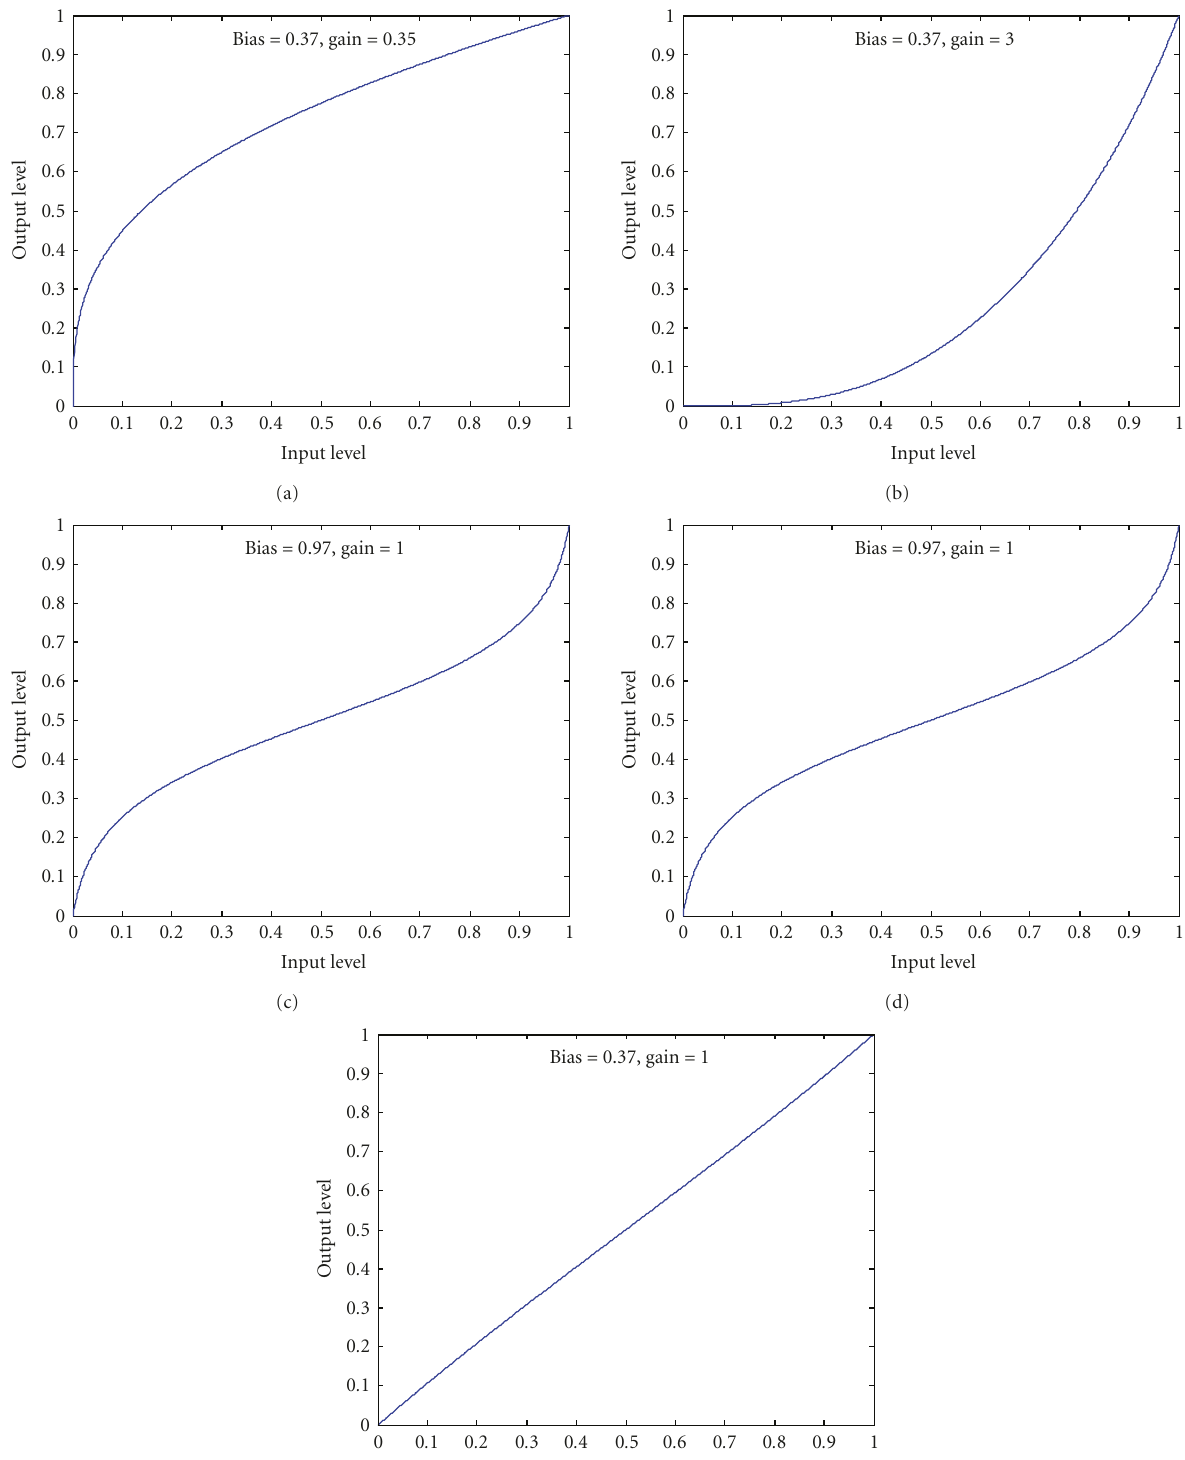
Figure 4: Five categories of commonly used gray level transform functions: (a) dark image, (b) bright image, (c) back-lighted image, (d) low-contrast image, and (e) high contrast